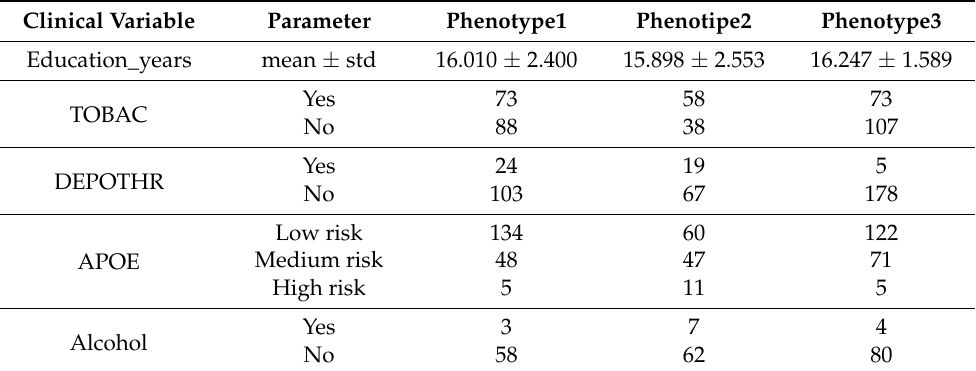
Table 4. Compilation of the total number of subjects in relation to some relevant epigenetic variables among the three A β -PET phenotypes determined for